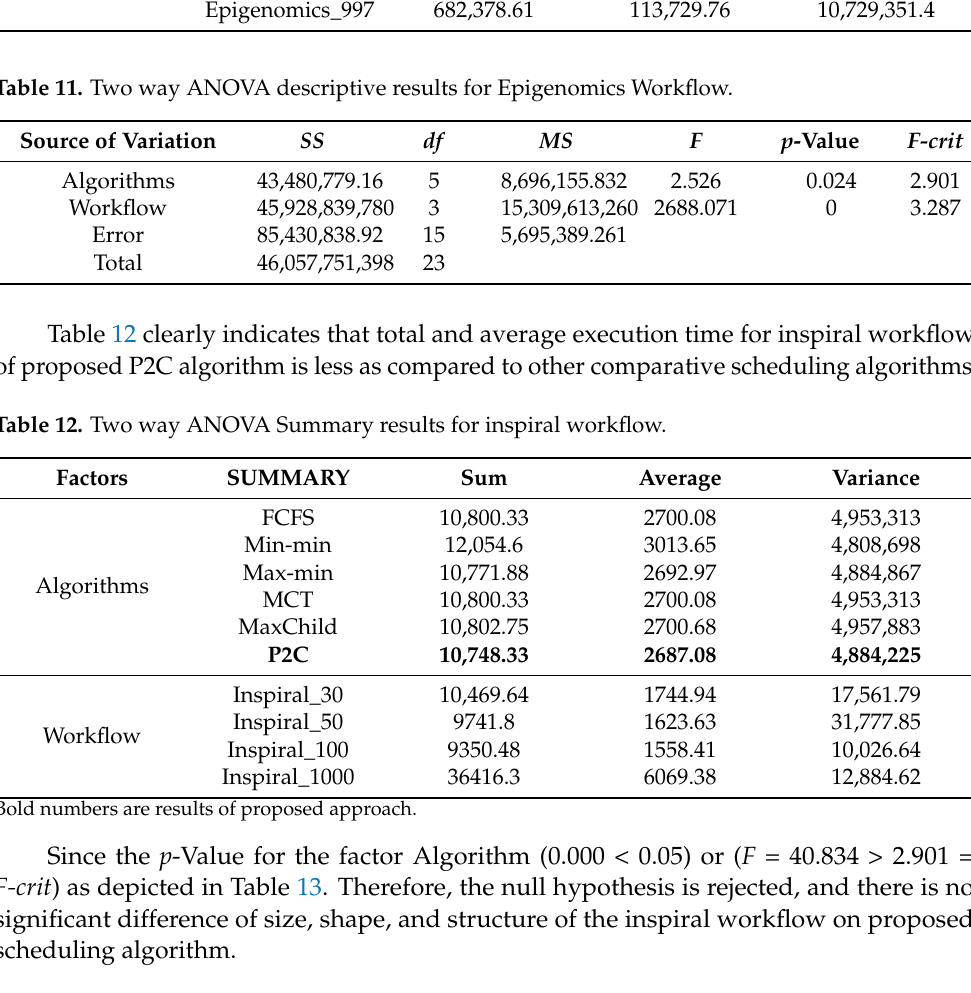
Table 13. Two way ANOVA descriptive results for inspiral